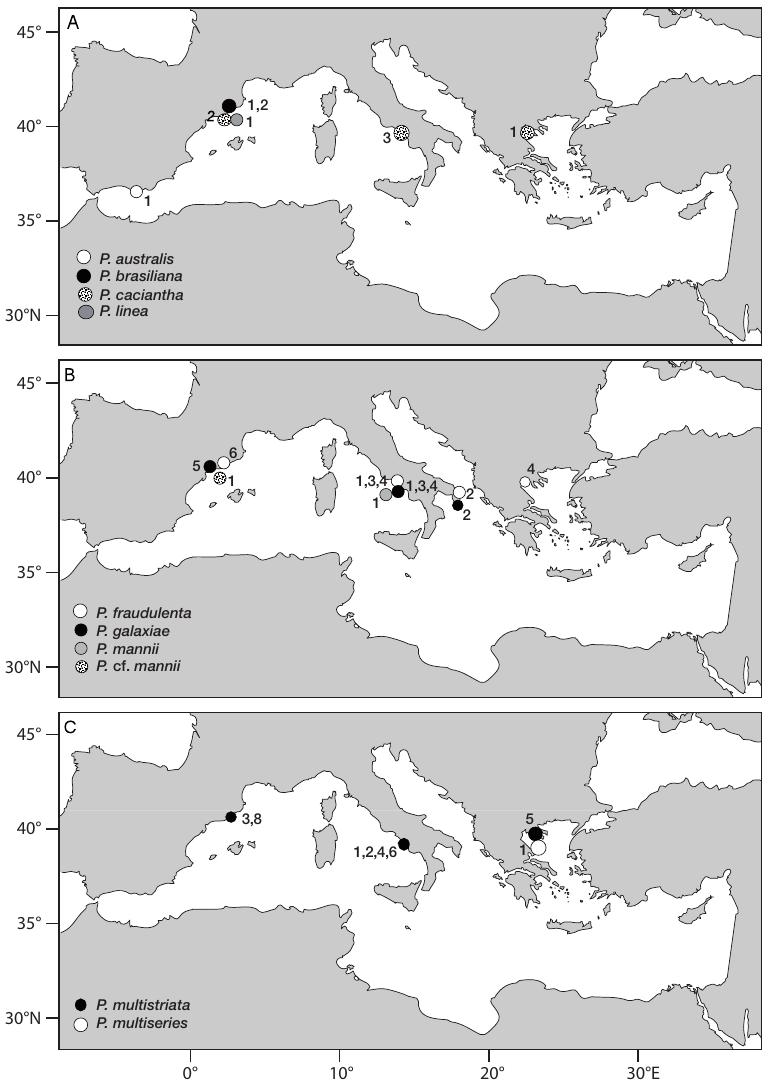
Fig . 5. – Geographic distribution of Pseudo-nitzschia in the Mediterranean Sea. See Table 6 for references and information of each